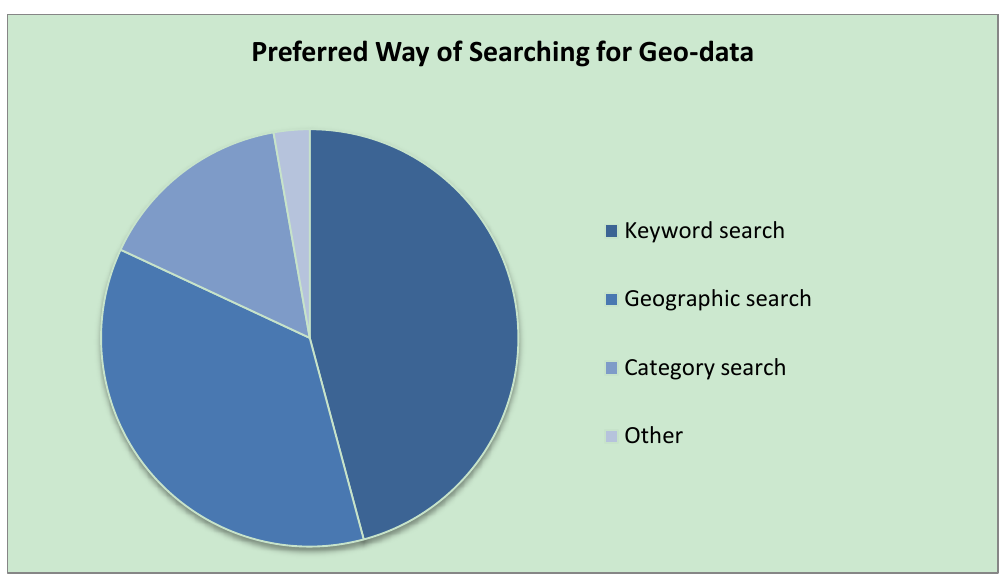
Figure 3. Preferred Way of Searching for